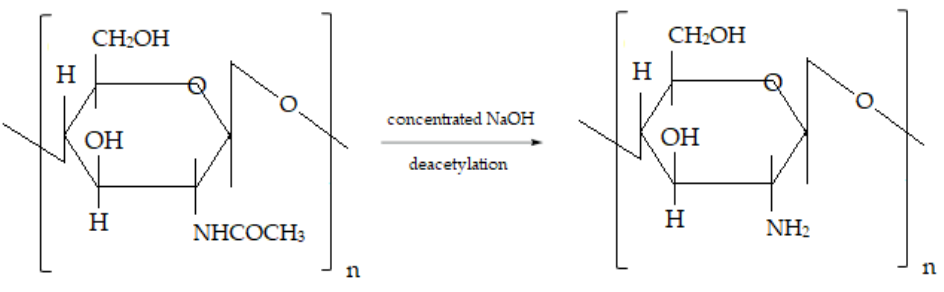
Figure 1. Chitin deacetylation into chitosan .